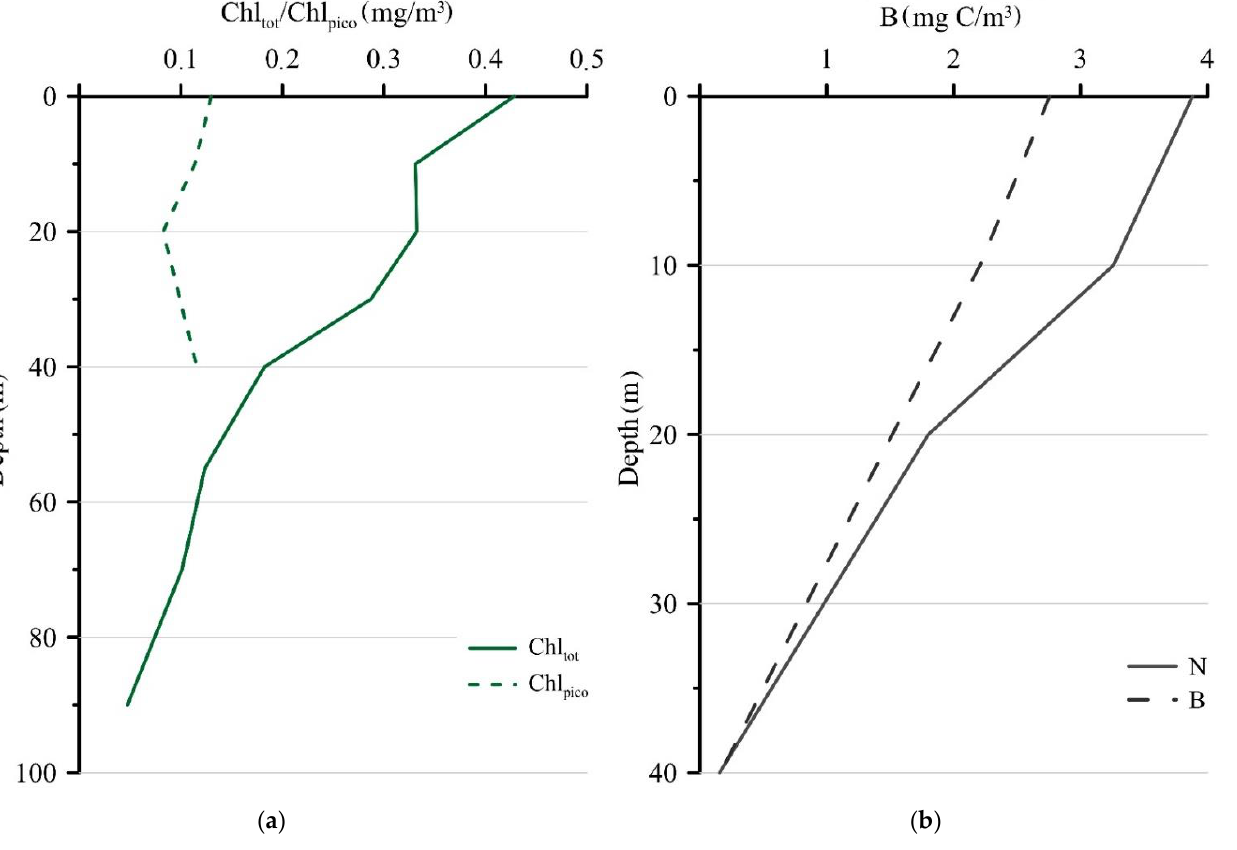
Figure 3. Vertical distribution of Chl tot and Chl pico (mg/m 3 ) ( a ), photosynthetic picoeukaryotes abundance (N, × 10 9 cells/m 3 ) and biomass (B, mg C/m 3 ) ( b ) at station 5976 during the setting of sediment trap in September